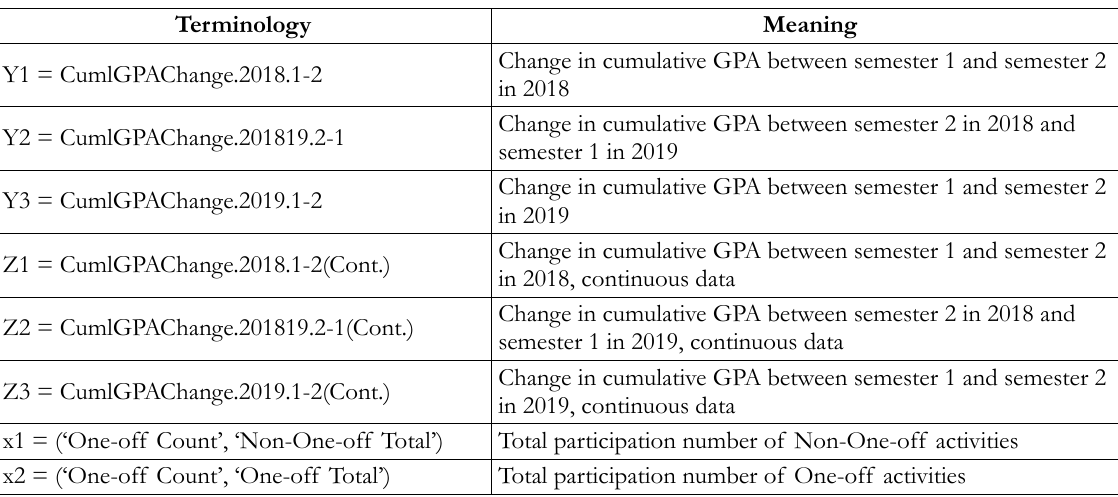
Table 1. Terminology of Graphs in Finding